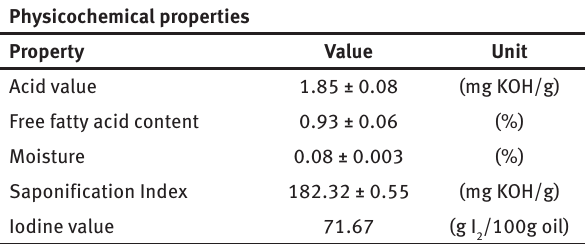
Table 1: Physicochemical properties of WCO. GC-MS configuration. Each value represents the mean of three replicates ±